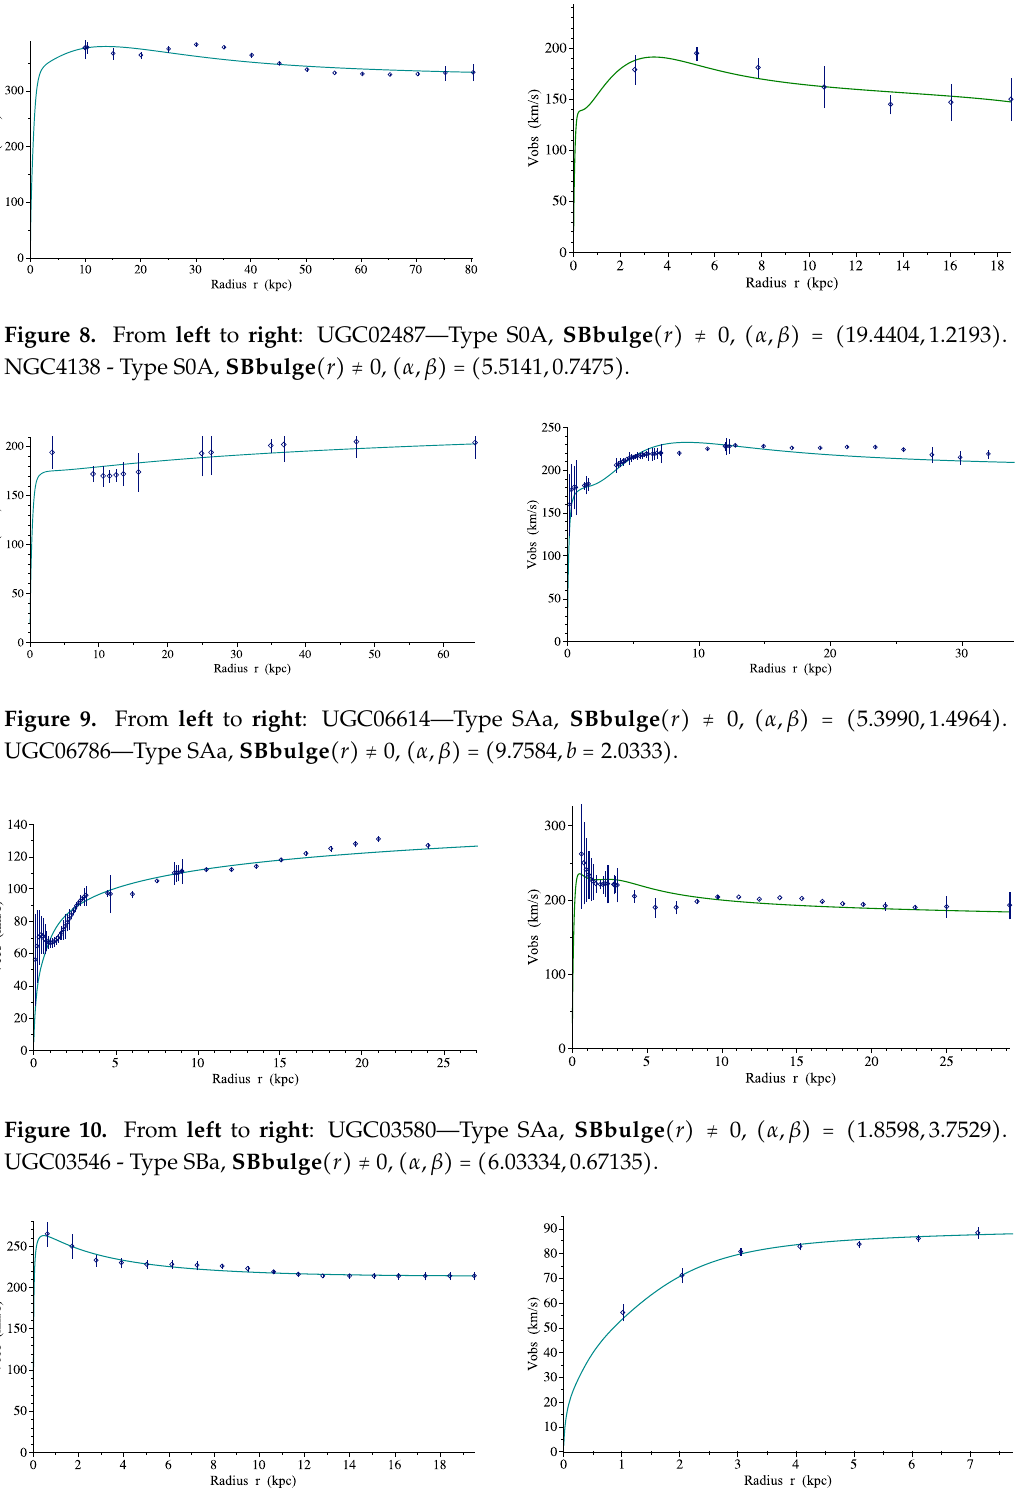
Figure 11. From left to right : NGC7814—Type SAab, SBbulge ( r ) ≠ 0, ( α , β ) = ( 9.0958,0.8154 ) . UGC02259 - Type Sdm, SBbulge ( r ) = 0, ( α , β ) = ( 38.5594,12.2014 )